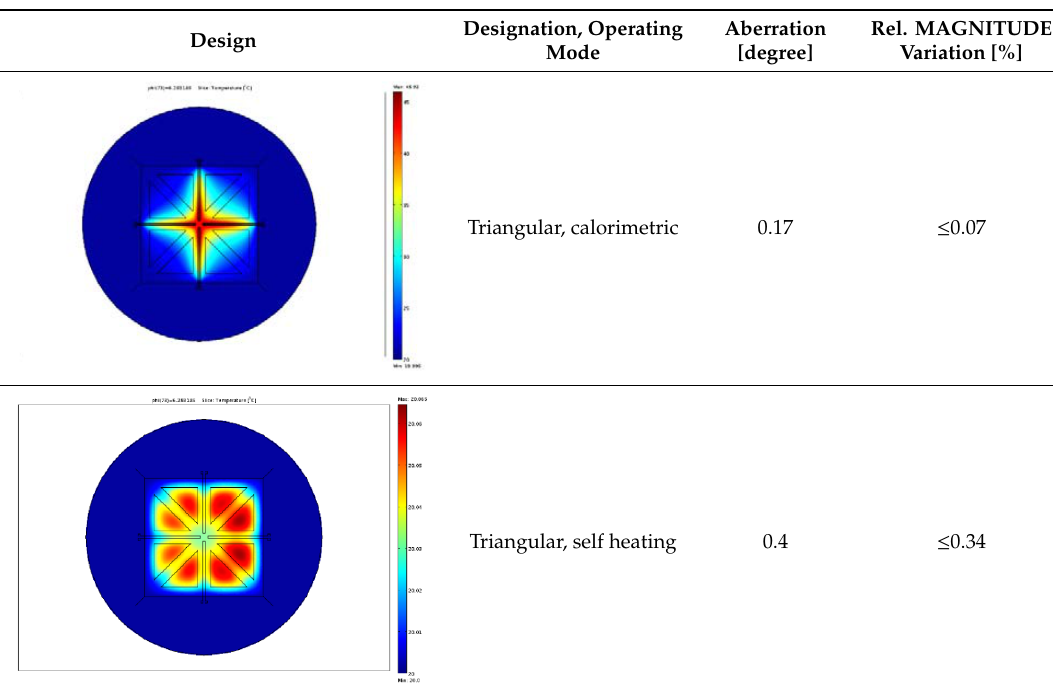
Table A1. List of twelve investigated membrane design with operating mode combinations, azimuthal aberration and magnitude